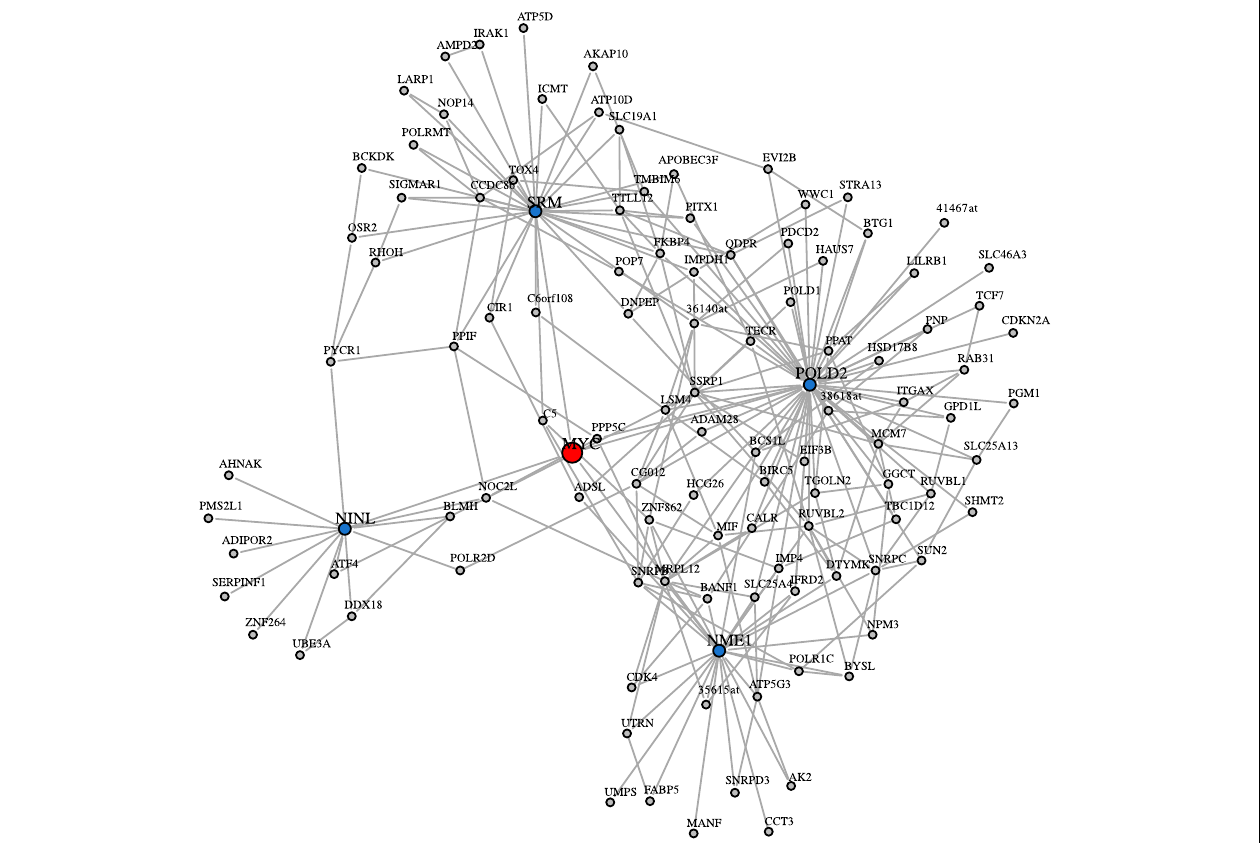
FIGURE 5 | BC3Net subnetwork including MYC (red) and its 2nd level nearest neighbors. The first degree MYC neighbors are shown in blue and the 2nd degree MYC neighbors are shown in